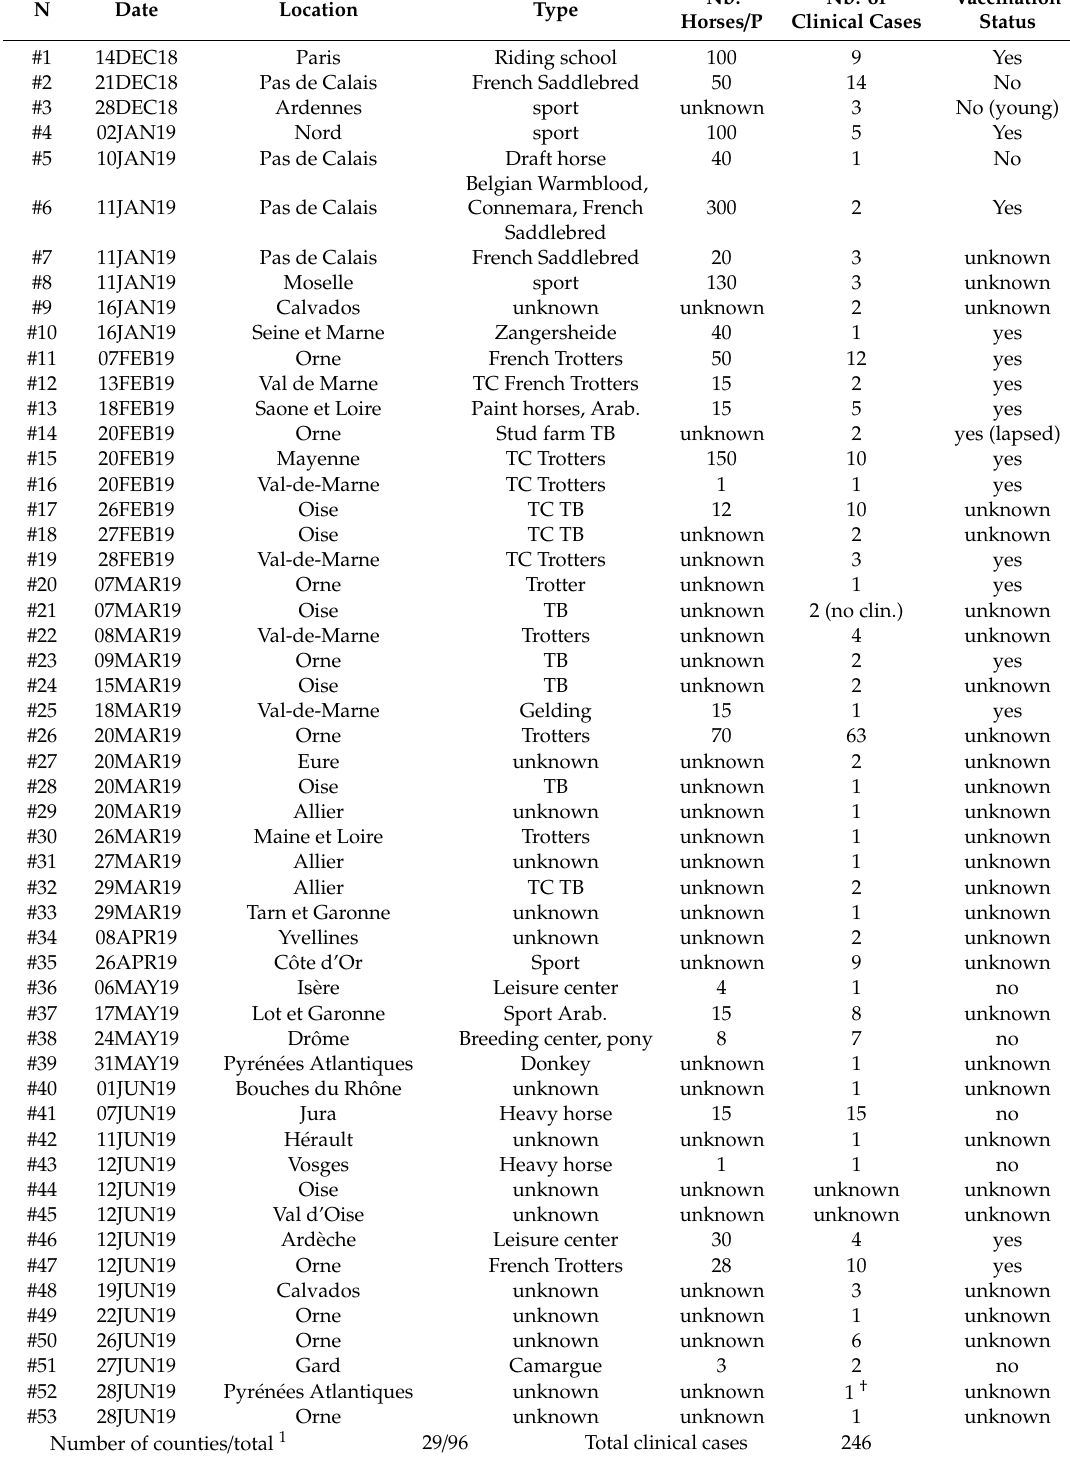
Table 1. Details of French equine influenza (EI) outbreaks, from late 2018 to June 2019. Data were recorded by field equine veterinary practitioners and collated by the equine pathology epidemiological surveillance network (RESPE) and the LAB É O Research and Diagnostic Institute. Arab. = Arabian horse; Type = type of premises and / or breed; TB = thoroughbred; TC = training center; Horse / P = number of horses on the